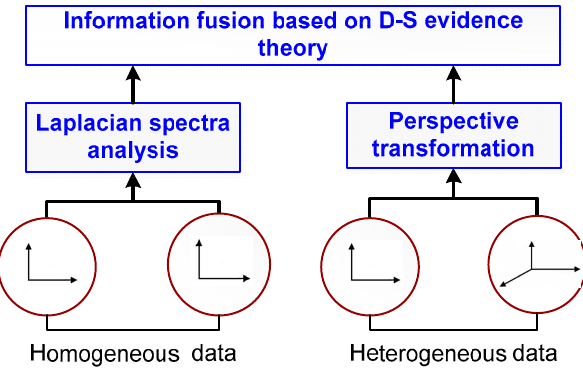
Figure 6. Multisource information fusion diagram for homogeneous signals and heterogeneous data.